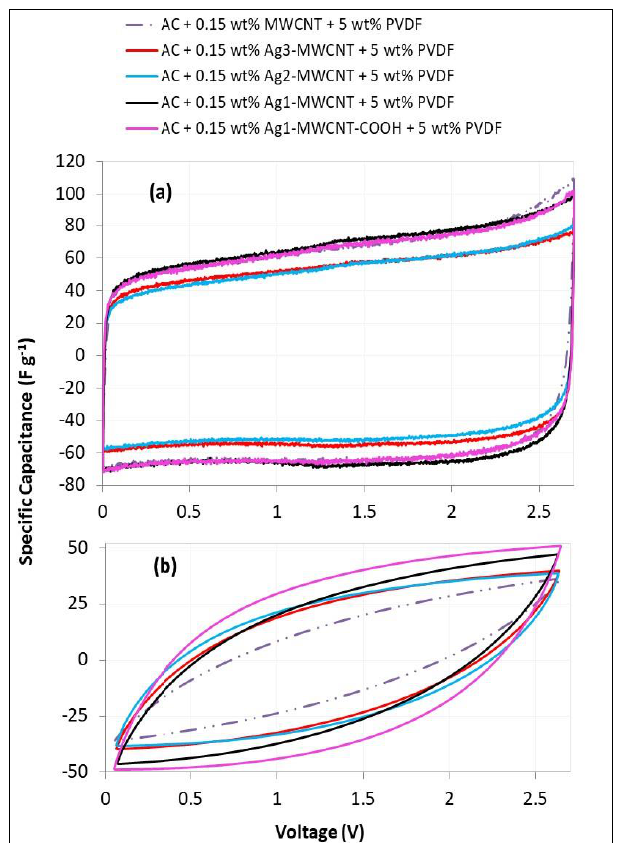
Figure 6. Cyclic voltammetry results for EDLCs with different types of composite electrode coatings: ( a ) at 0.01 V · s − 1 ; ( b ) at 1 V · s − 1 . The vertical axis is specific electrode capacitance, representing the capacitance (F) of a half cell per mass (g) of one composite electrode. Average C el,sp values from integration over a whole CV cycle at 0.01 V · s − 1 (Figure 6a) ± standard error from two tested sample cells in each case: AC + 0.15 wt% MWCNT + 5 wt% PVDF coating: 63.92 ± 0.03 F · g − 1 ; AC + 0.15 wt% Ag1-MWCNT + 5 wt% PVDF: 65.91 ± 0.03 F · g − 1 ; 0.15 wt% Ag2-MWCNT + 5 wt% PVDF: 51.69 ± 0.03 F · g − 1 ; 0.15 wt% Ag3-MWCNT + 5 wt% PVDF: 53.82 ± 0.03 F · g − 1 ; 0.15 wt% Ag1-MWCNT–COOH + 5 wt% PVDF: 63.88 ± 0.03 F · g − 1 .